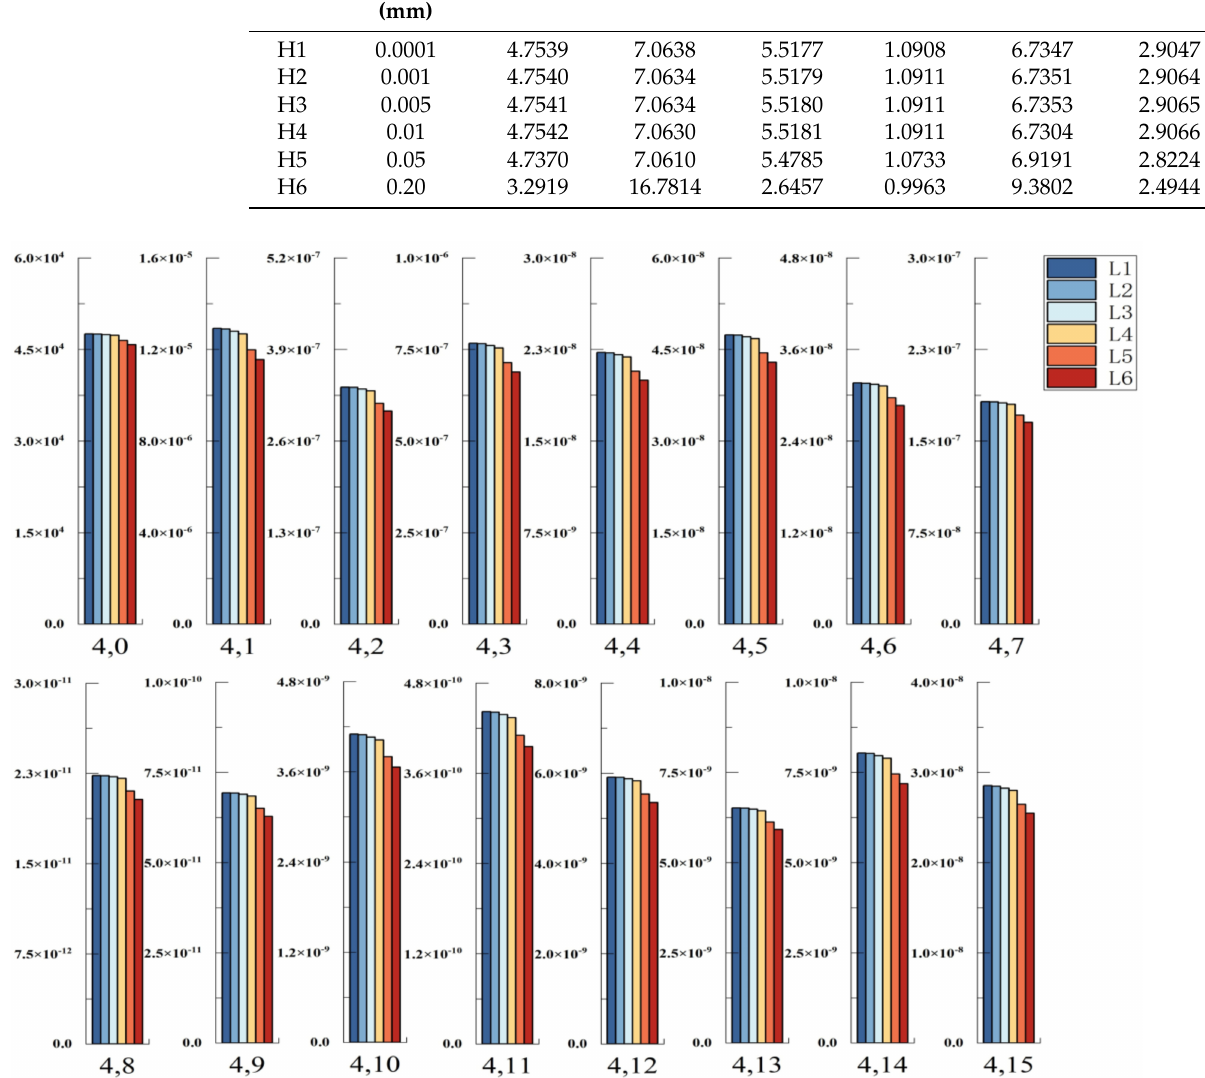
Figure 25. Characteristic energy of wavelet packet of piston side pressure when hydraulic cylinder leaks.